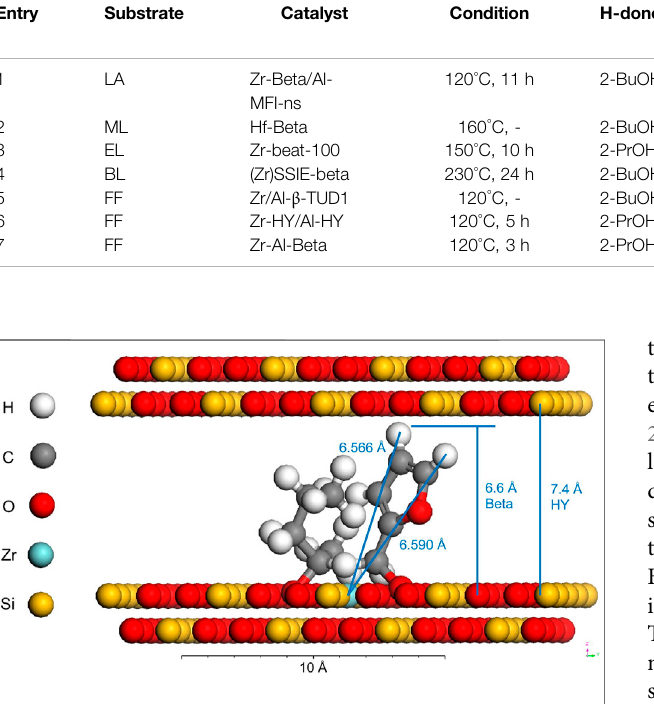
FIGURE 2 | The model of the spatial limitation of the coordination of the catalyst and the substrate in the pore channel [copyright from Zhang et al.